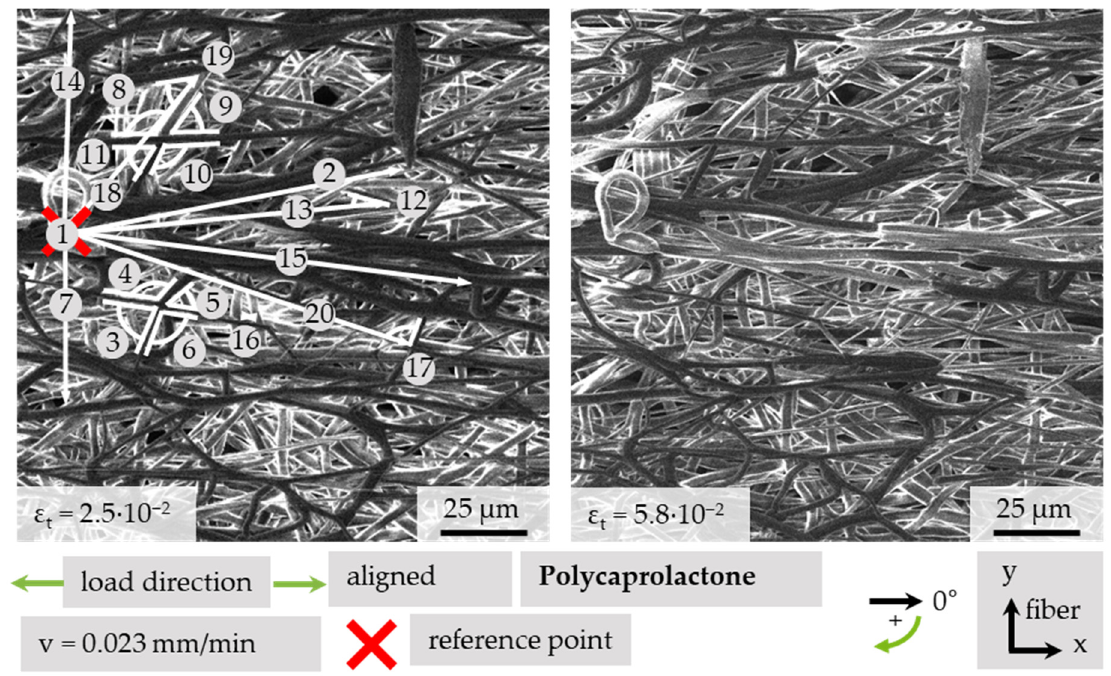
Figure 10. Measurement of fiber movement of PCL due to tensile testing. Table 2. Distances and angle of two strain conditions of aligned PCL under tensile load as marked in Figure 10.